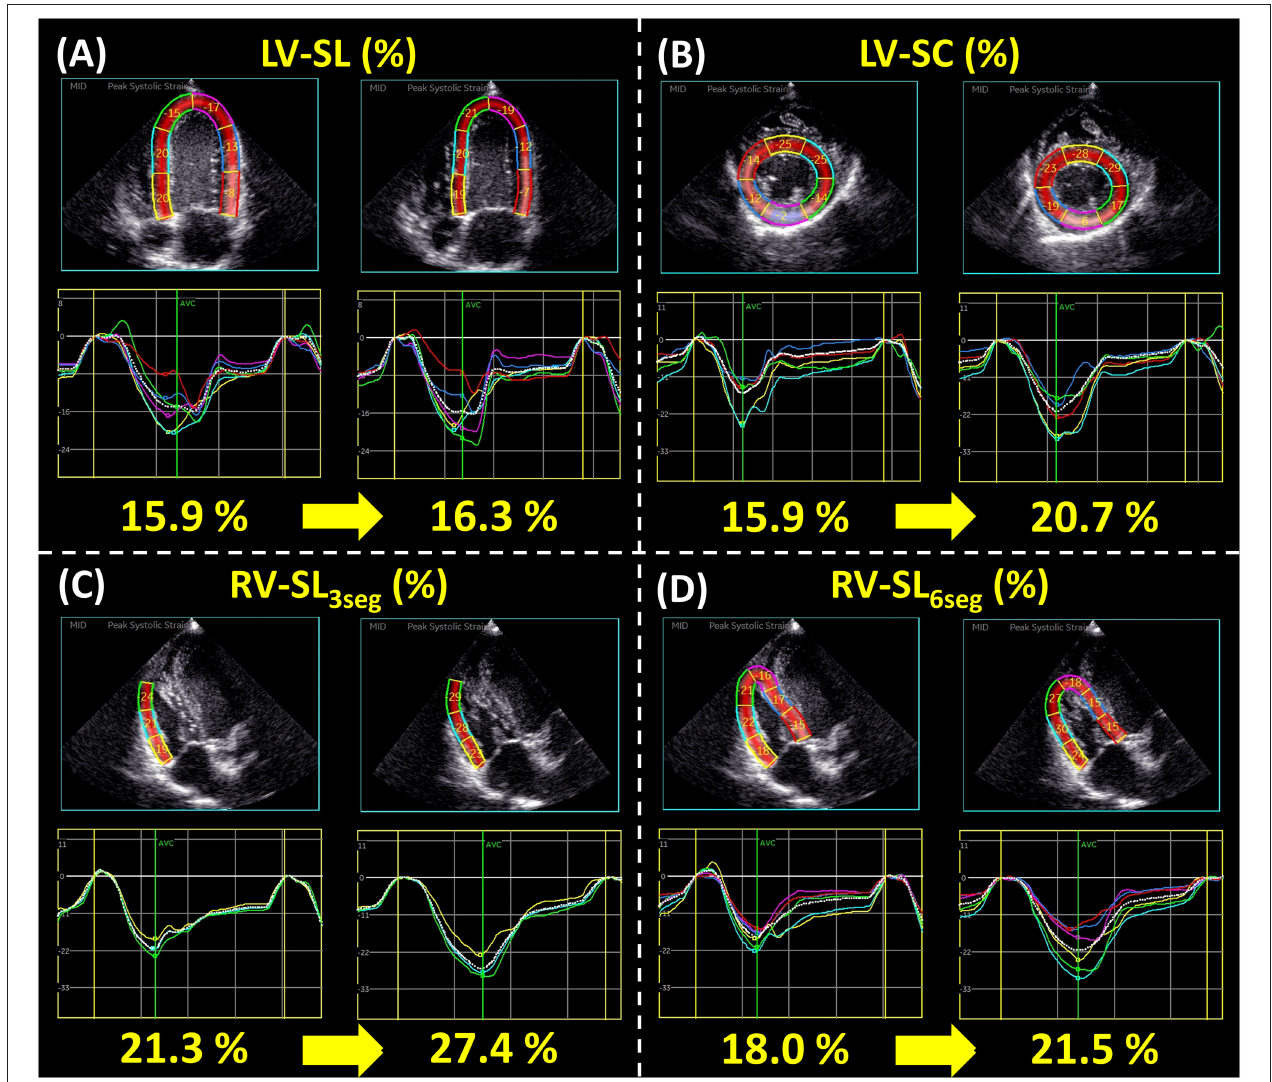
FIGURE 2 | Representative data of two-dimensional speckle tracking echocardiography-derived myocardial strain before and after 15 µ g/kg beraprost sodium (BPS) administration: left ventricular longitudinal strain [LV-SL (A) ], left ventricular circumferential strain [LV-SC (B) ], right ventricular longitudinal strain obtained from only right ventricular free wall analysis and right ventricular global analysis [RV-SL 3seg (C) and RV-SL 6seg (D) , respectively]. For each variable, the left figure represents the myocardial strain before BPS administration, and the right represents that after BPS